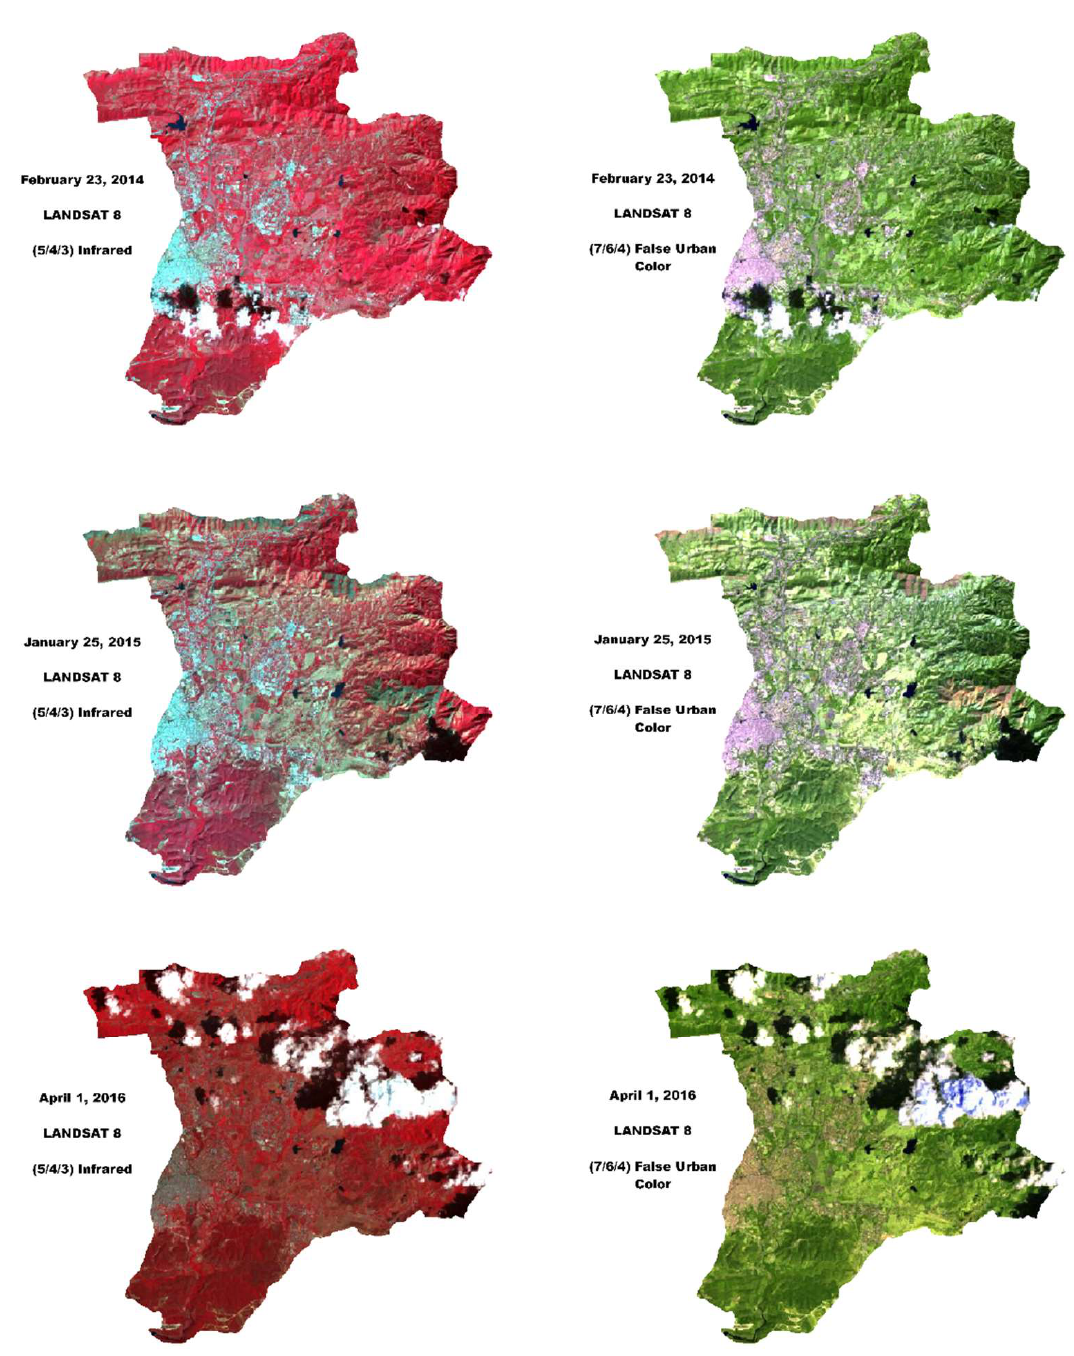
Figure A1. Satellite Band Composition Obtained.